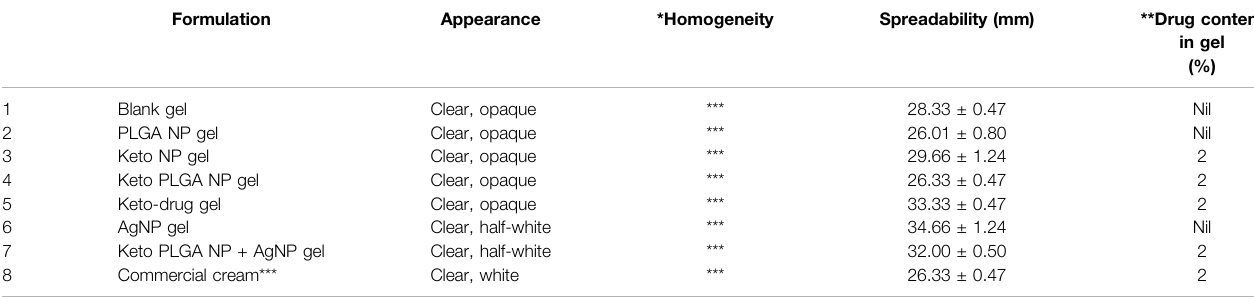
TABLE 6 | Physicochemical characteristics of optimized gel formulations.